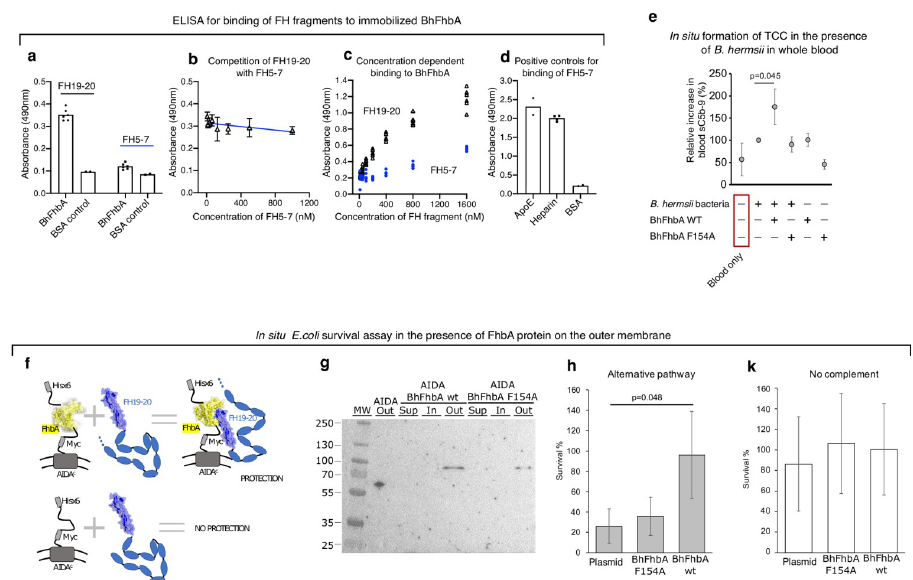
Fig 3. BhFbA affects complement activation and survival. (a) Binding of FH19-20 and FH5-7 to immobilized BhFhbA detected by ELISA. Individual data points are shown with bars indicating mean values. Values shown in panels a-e are absorbances measured by ELISA. (b) Effect of FH5-7 on binding of FH19-20 to immobilized BhFhbA detected by ELISA. n = 5 or more. Error bars represent S.D. (c) Concentration-dependent binding of FH19-20 and FH5-7 to BhFhbA. Individual data points from several ELISA assays are shown. (d) Controls for FH5-7 fragment confirmed by ELISA. Binding to ApoE [65] protein and heparin were used as positive controls, and BSA as negative control. Individual data points from assays are shown, and bars indicate mean values. (e) Complement activation measured by formation of soluble terminal complement complexes (TCC) in whole blood. Proteins added to reactions are shown below the graph. Data are presented as relative TCC-amount (%) compared to the sample where bacteria alone were incubated in blood (n = 4, error bars represent S.D.) Difference between bacteria alone to bacteria incubated with wild type FhbA ( � p < 0.05) calculated by paired t -test (Mann-Whitney U-test for independent samples). (f) Schematic representation of the survival assay using the AIDA-1 transport system 44 , where binding of membrane expressed FhbA to serum FH protects E . coli against complement attack. (g) Western blot showing the presence of His- tagged BhFhbA on the outer surface of E . coli . Outer membrane sample of E . coli expressing an empty AIDA1 system shows a band present at about 63 kDa, consistent with the expected molecular weight (lane 2). BhFhbA wt and Fhe154Ala mutant proteins are present only in outer membrane (out) at the expected molecular weight of 83 kDa (lanes 5 and 8). The anti-His signal was not detected in the supernatant fraction (sup) or in the inner membrane (in). (h) Serum survival of E . coli clones expressing BhFhbA, BhFhbA mutant F154A and empty vector (AIDA) as a control. Result was calculated as a percentage of bacteria that survived after 15 min incubation in serum as compared to the number of bacteria at time point zero (n = 4, error bars represent S.D.) Difference between BhFhbA clone to control significant ( � p < 0.05)calculated by one-way ANOVA supplemented with Dunnet’s test for unequal variances. (i) Survival of E . coli clones expressing BhFhbA, BhFhbA mutant F154A and empty vector as a control in the presence of inactivated (with 10 mM EDTA) serum without complement. Result was calculated as a percentage of colonies surviving after 15 min incubation in media as compared to the number of bacteria at time point zero (n = 3, error bars represent